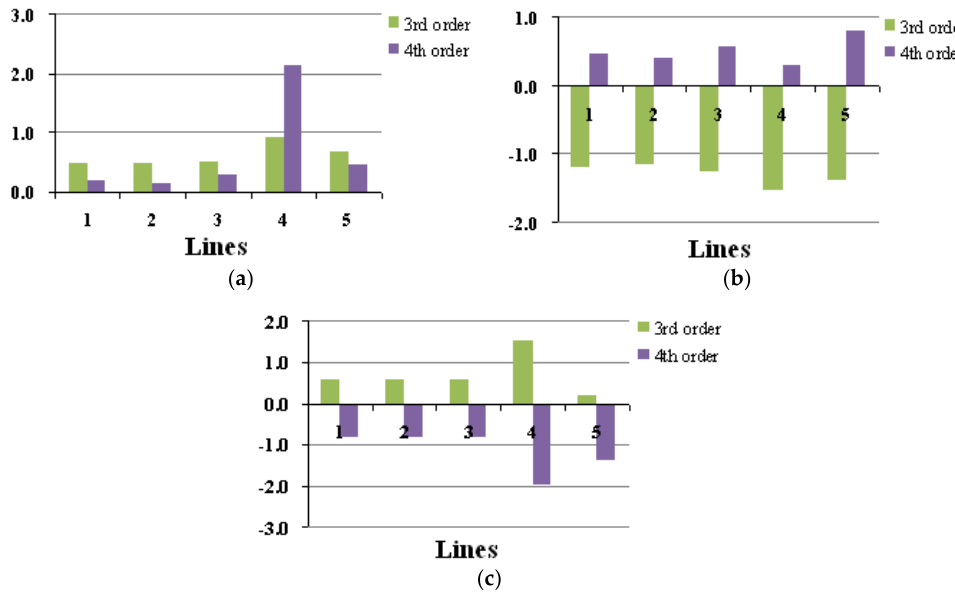
Figure 8. Current distributions of each order for the SLGF on different five lines by using the SK. ( a ) Phase A; ( b ) Phase B; and ( c ) Phase C.